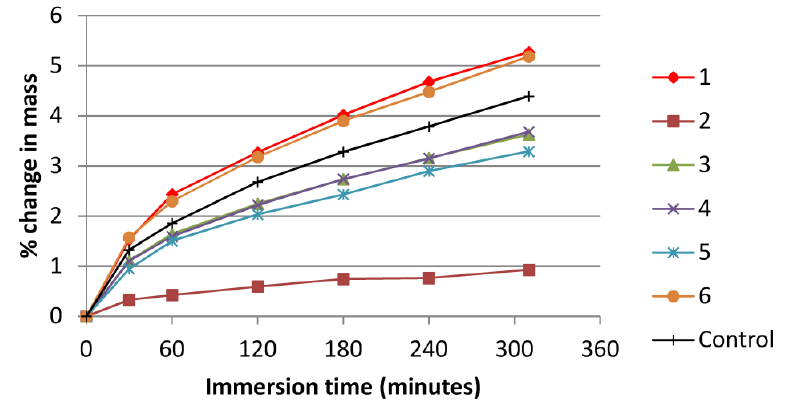
Figure 5. Percentage change in squeegee mass during immersion in solvent blend used in carbon (wear) ink.